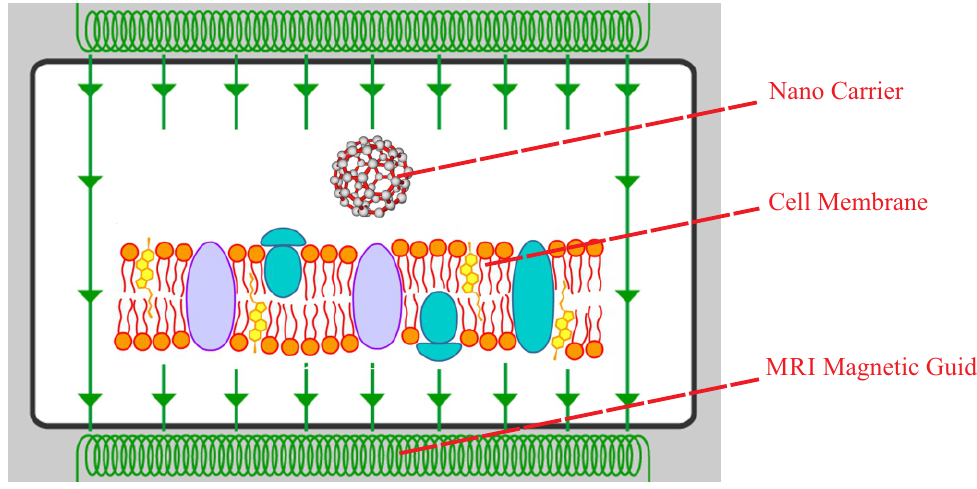
Figure 1. Schematic model of the nanocarrier passing through the membrane using the MRI